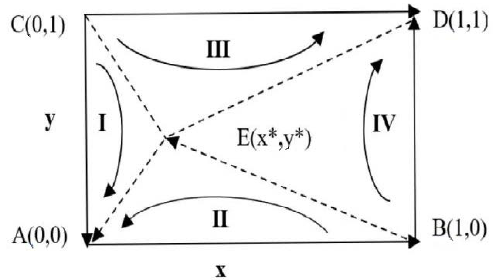
Figure 1. System evolution phase diagram.